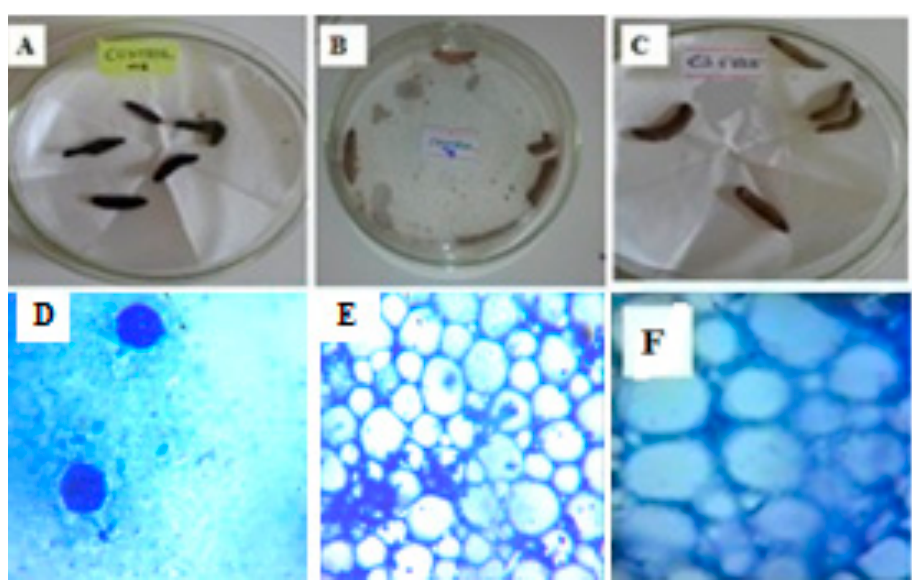
Figure 11. ( A , D ) Infected larvae (Positive control) and their appearance under the microscope at the magnification of 100×; ( B , E ) Non-infected Larvae (Negative control) and their appearance under the microscope at the magnification of 100×; ( C , F ) Larvae injected with Free CS/TPP and their appearance under the microscope at the magnification of 100×.